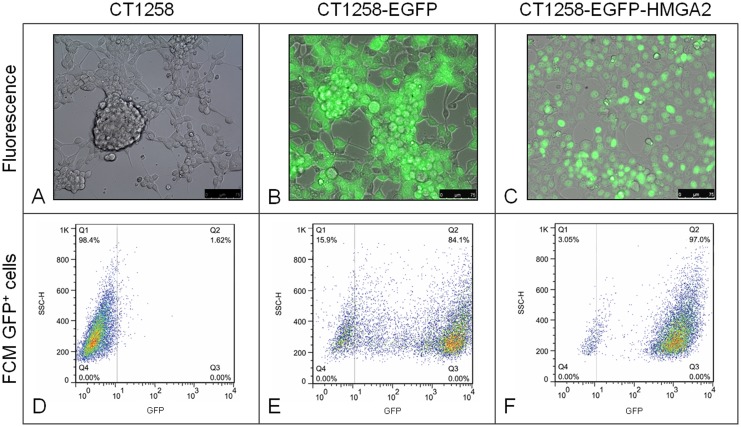
Fluorescence microscopy and flow cytometry analyses.A: Transmitted light image of the characteristic growth pattern of native CT1258 cells. B: Merged image of EGFP expressing CT1258-EGFP cells; EGFP is localised in the cytoplasm. C: Merged image of CT1258-EGFP-HMGA2 cells expressing the nuclear localised EGFP-HMGA2 fusion protein. D–F: Flow cytometric analyses of EGFP expression in the three CT1258 cell lines depicted in dot-plots showing side scatter (SSC) vs. EGFP fluorescence. No GFP fluorescence is detectable in native CT1258 cells (D), 84.1% of EGFP-positive cells are present in the CT1258-EGFP cell line and (F) 97.0% EGFP-positive cells in CT1258-EGFP-HMGA2. Per sample 1×104 events were analysed.